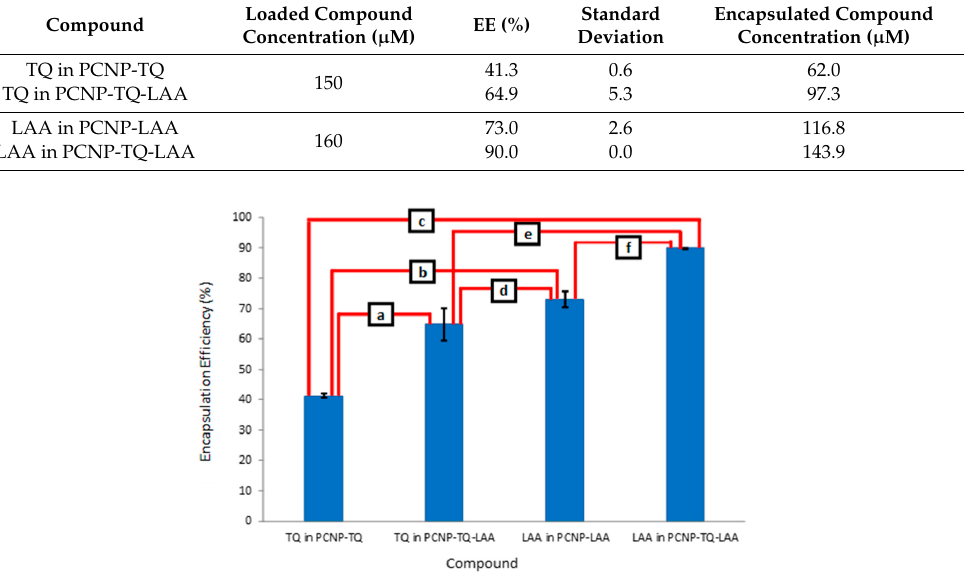
Figure 8. The percentage encapsulation of TQ in PCNP-TQ, TQ in PCNP-TQ-LAA, LAA in PCNP-LAA, and LAA in PCNP-TQ-LAA. A t -test was conducted to see the significance of the percentage encapsulation changes between samples. The confidence level was set to 95% and the results are labelled as a to f. (a) Significant ** with a p -value of 0.0097, (b) significant *** with a p -value of